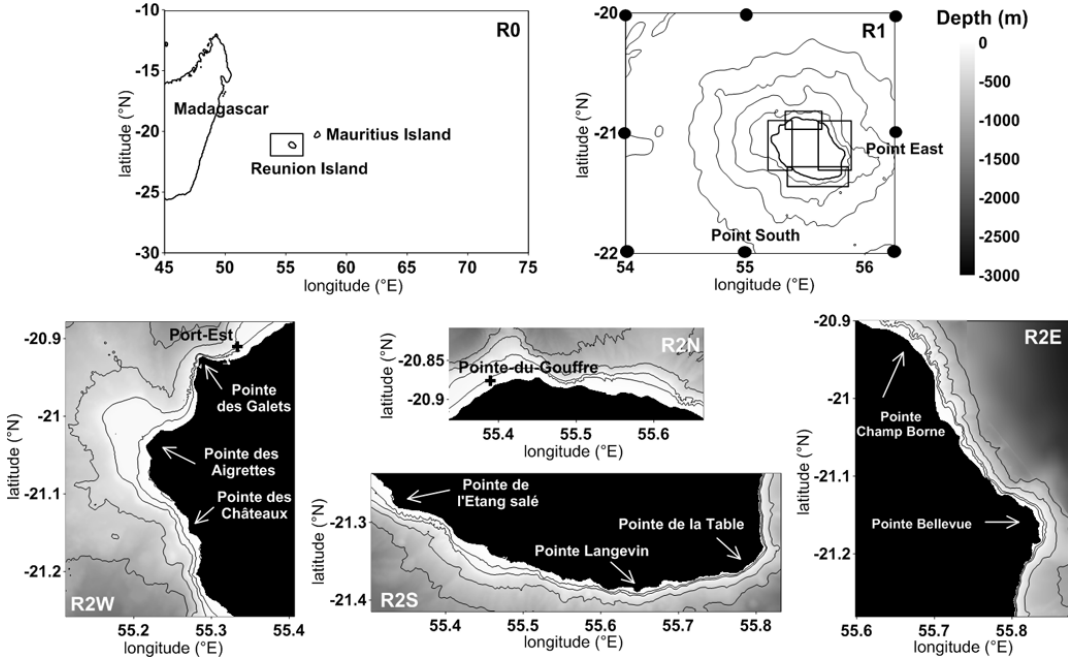
Fig. 6. Nested grids used for the modelling of waves with